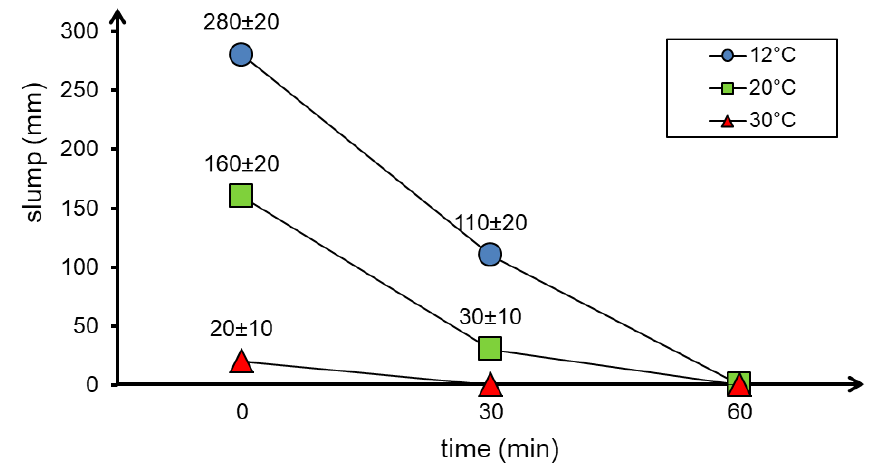
Figure 3. Results of concrete mixture consistency tests with the use of the slump test depending on the temperature and time of